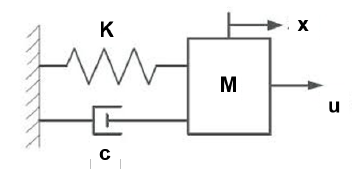
Figure 3. Mass-spring-damper (MSD) mechanical system schematic.